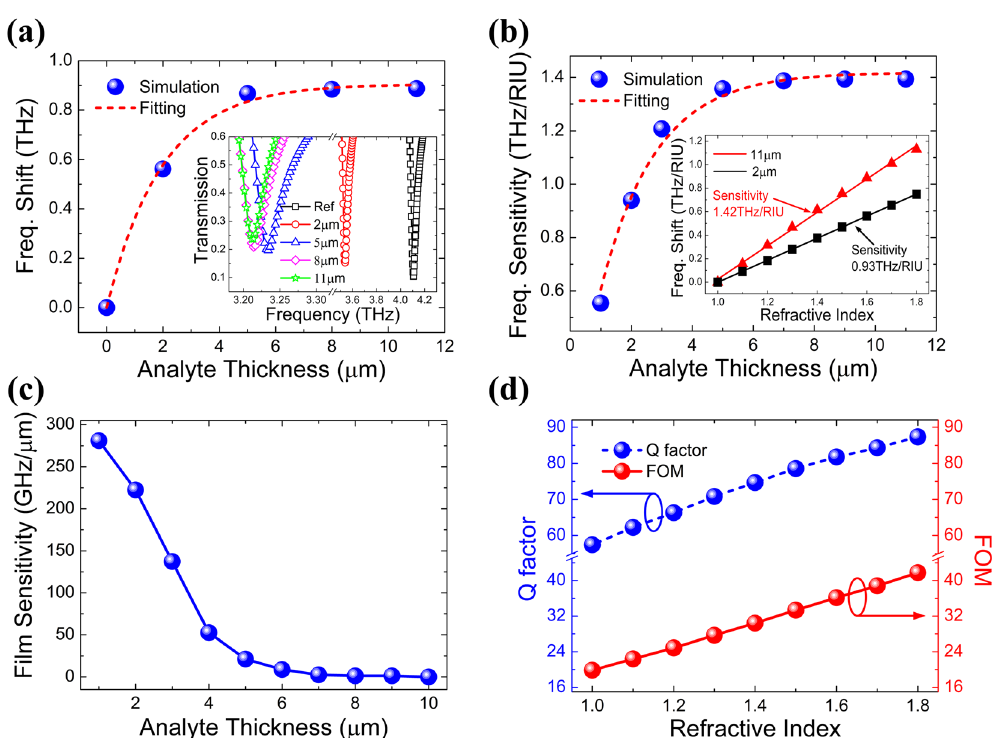
Figure 4. ( a ) Frequency shift of the MMs structure with different analyte thicknesses, the red dotted line is the exponential fitting to the simulation data (blue sphere). The inset shows the simulated transmission dips with different analyte thicknesses. ( b ) The frequency sensitivity versus different analyte thicknesses, the inset shows the sensitivity with 2 μ m and 11 μ m analyte layer. ( c ) The film thickness sensitivity versus analyte thicknesses. ( d ) Variation of Q factor and FOM with different refractive indices of the